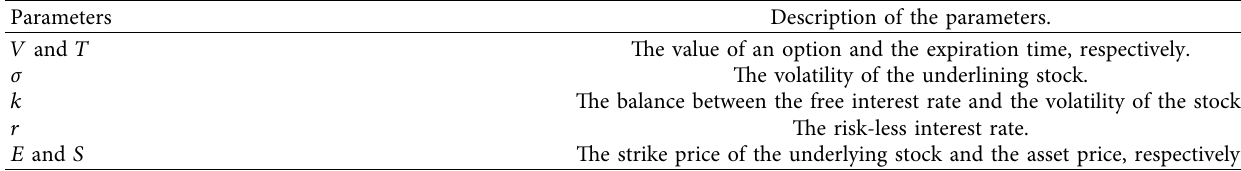
Parameters Description of the parameters.